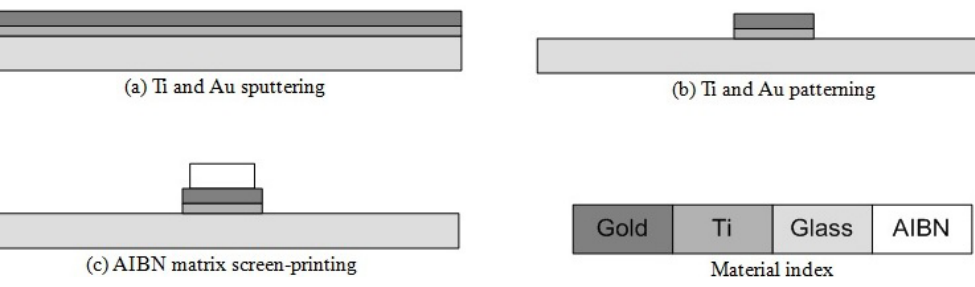
Figure 4. The fabrication process flow of the gas source